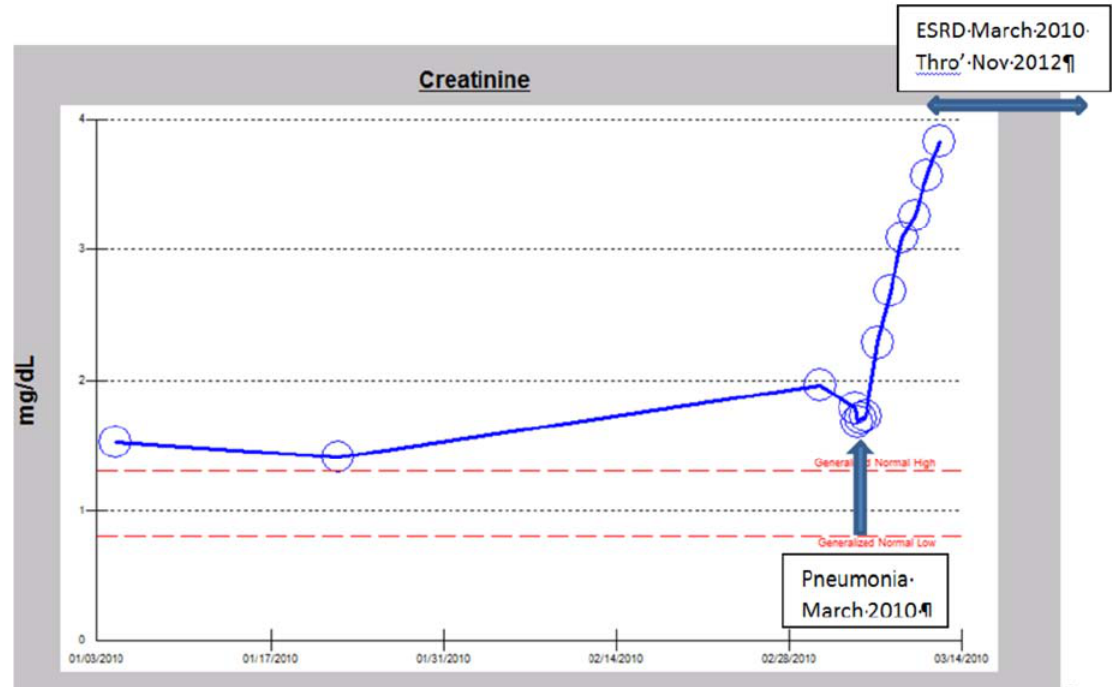
Figure 2. Serum creatinine trajectory demonstrating rapid-onset, acute yet irreversible ESRD requiring RRT following pneumonia in an obese, hypertensive, diabetic male Caucasian with III CKD in March